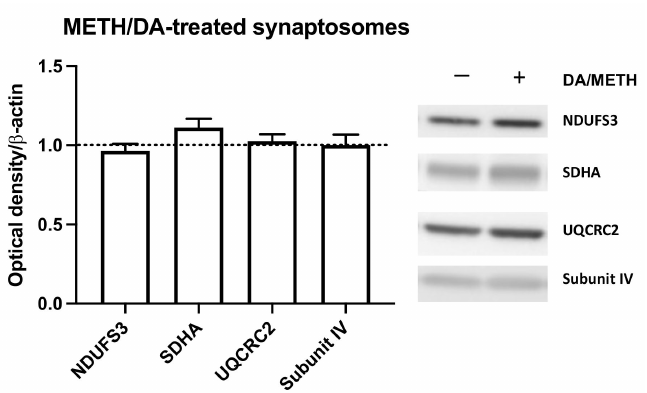
Figure 6. Effects of 10 mM DA and 10 µ M METH on synaptosomal mitochondria: subunit NDUFS3 (complex I), SDHA (complex II), UQCRC2 (complex III), and subunit IV (complex IV). No statistically significant changes were observed in DA- and METH-treated synaptosomal mitochondria suspended in the cytoplasm compared to phosphate-buffered saline (PBS)-treated mitochondria. DA and METH data were normalized to the PBS data, shown as a dotted